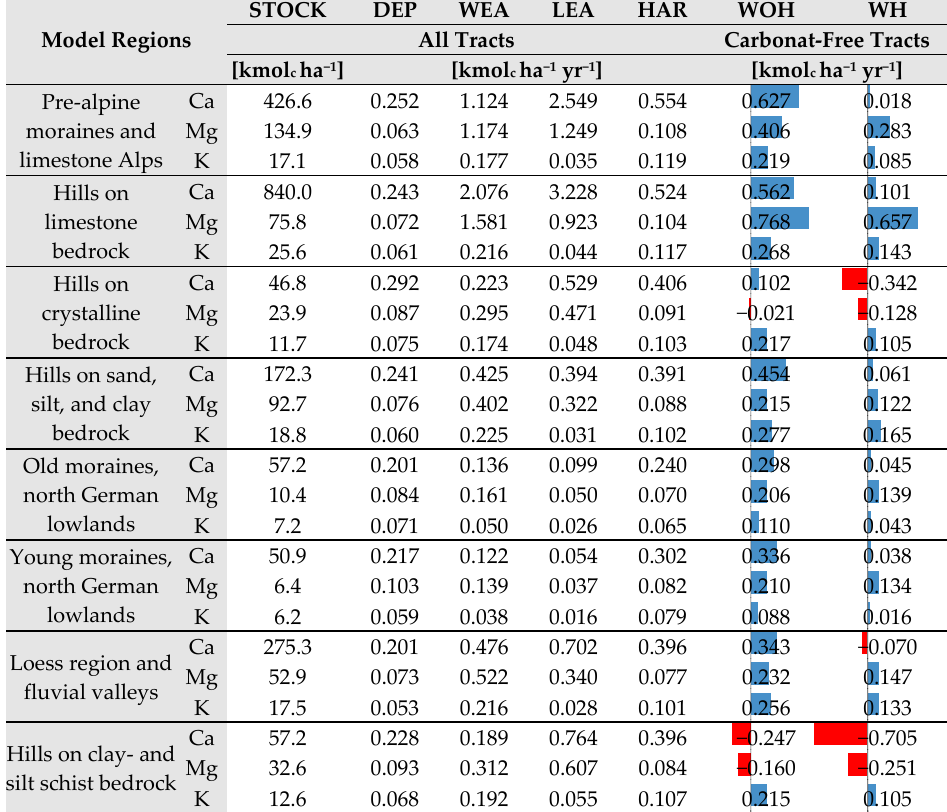
Table 2. Medians of the nutrient balances on the NFI tracts stratified by model regions (Ca and Mg only for carbonate-free soils) for the harvest scenario REAL. DEP: deposition; WEA: weathering; LEA: leaching; HAR: harvest removal; WOH: balance without harvesting; WH balance with harvesting.